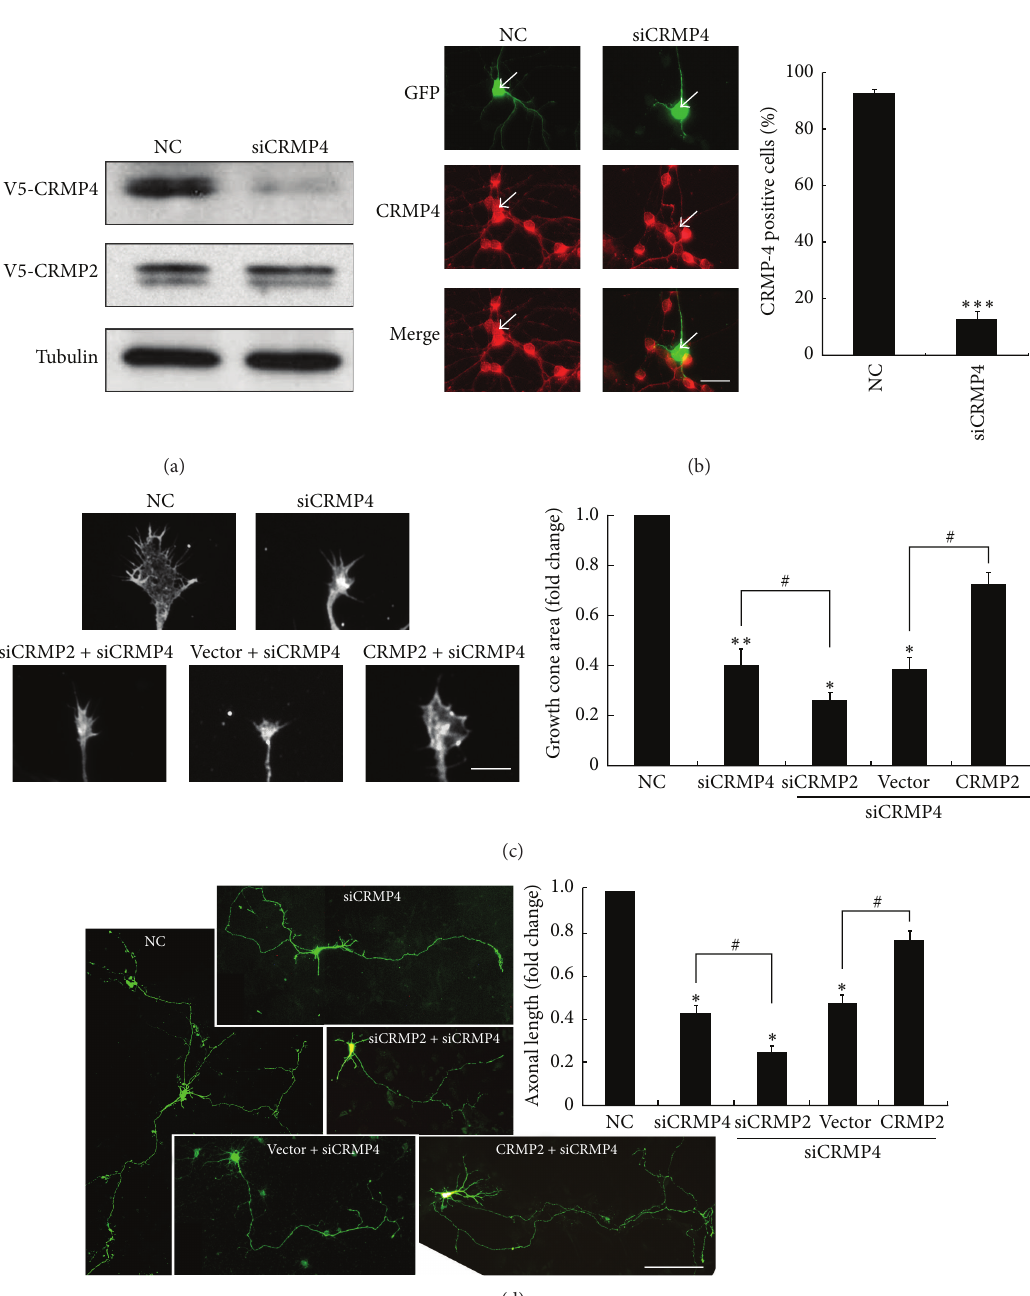
Figure 4: Both CRMP2 and CRMP4 are necessary for growth cone development and axonal elongation, and CRMP2 rescues the inhibitory effect of CRMP4 knockdown. (a) The efficiency of CRMP2 siRNA was measured in HEK293 cells by transfection with a nontargeting siRNA (negative control, NC) or the siCRMP4 fragment together with the CRMP4-V5 plasmid. Cell lysates of HEK293 cells were analyzed using western blotting with the V5 antibody. Tubulin was used as a loading control. (b) Neurons at 1 day in vitro (DIV) were transfected with GFP together with the CRMP4 siRNA fragments or NC. Neurons were stained with anti-GFP (green) and anti-CRMP4 (red). Representative images are shown (left panel). The percentage of CRMP4-positive GFP-transfected neurons (right panel). Mean ± SEM, 𝑛 = 3 ; ∗∗∗ 𝑃 < 0.001 versus NC. (c) Representative images of growth cones from neurons of the indicated transfections. Scale bar: 10 𝜇 m. The relative ratio of the growth cone area of transfected cells was measured and is shown in the right panel. Mean ± SEM, 𝑛 = 3 ; ∗ 𝑃 < 0.05 versus NC; # 𝑃 < 0.05 versus indicated control; ∗∗ 𝑃 < 0.01 versus NC. (d) Hippocampal neurons were transfected with indicated plasmids or siRNA fragments together with GFP. Neurons were fixed at 4 DIV and stained with a GFP antibody. Axon length was measured as the mean ± SEM from three independent experiments. ∗ 𝑃 < 0.05 versus NC; # 𝑃 < 0.05 versus indicated control. Scale bar: 100 𝜇